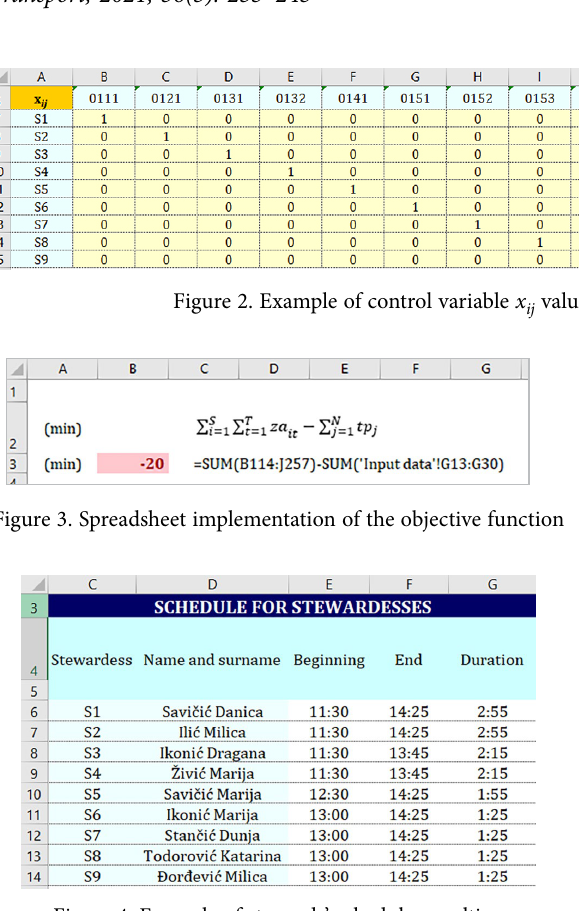
Figure 4. Example of stewards’ schedule, resulting from the